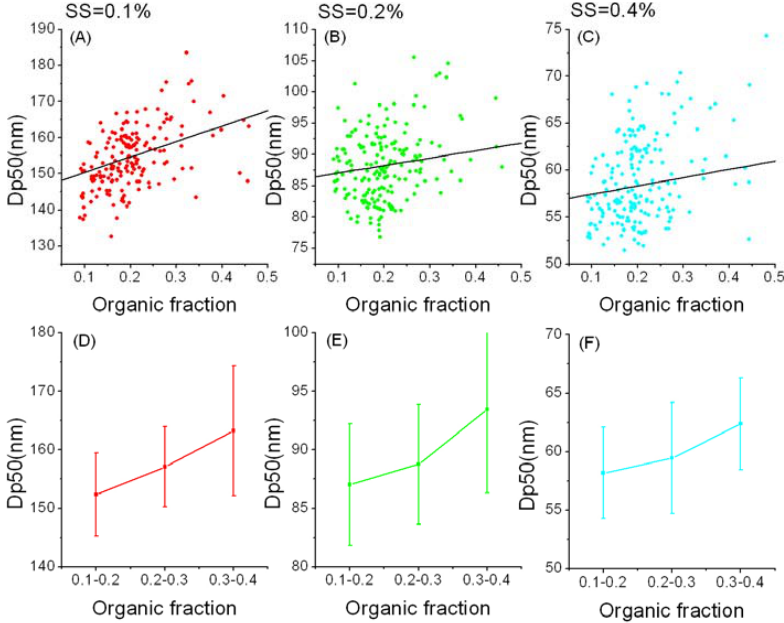
Fig.3 The relation of Dp50 with organics fraction under SS of 0.1%, 0.2% and 0.4% 3 Fig. 3. The relation of D p 50 with organics fraction under SS of 0.1%, 0.2% and 0.4%